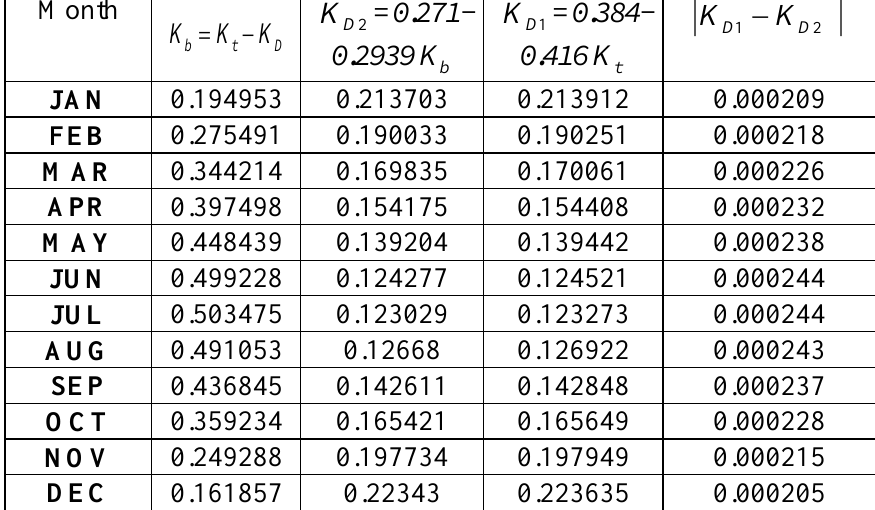
Table 3: The direct transmittance kb resulted from equation (3) was applied in equation